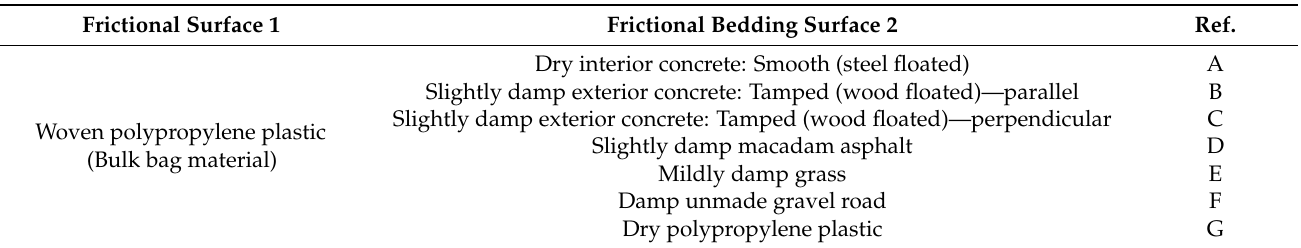
Table 1. Frictional surfaces tested within the fieldwork program.